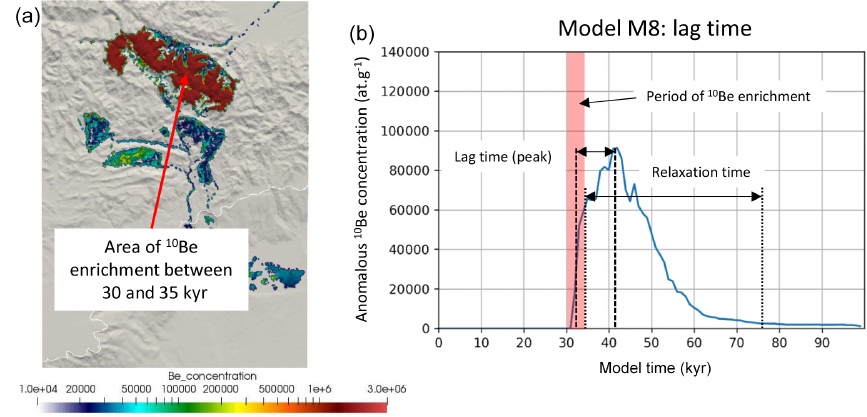
Figure 7. Difference in 10 Be MS between two models with the same parameters (Table 3), one of them having imposed 10 Be-rich (2 × 10 6 at.g − 1 ) rocks above 1800m between 30 and 35kyr (transparent red vertical strip in panel b ). Panel (a) shows the location of the area of 10 Be enrichment in the Mercantour massif. The time lag (thick dashes) is defined as the interval between the middle of the 10 Be enrichment period in the massif and the age of the largest 10 Be peak in marine sediments. The relaxation time is defined as the interval between the end of the 10 Be enrichment period in the massif and the end of excess 10 Be recorded in marine